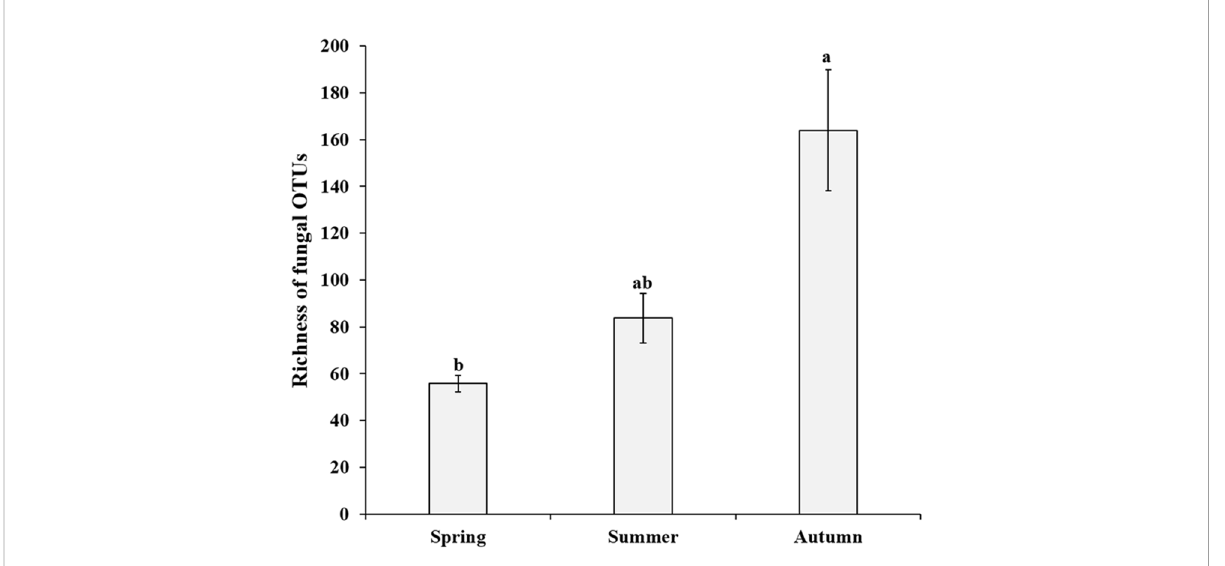
FIGURE 1 Richness of fungal operational taxonomic units (OTUs) of P. mongolica roots over three consecutive seasons. Bars without shared letters indicate signi fi cant differences in richness of fungal OTUs according to Tukey ’ s HSD at P <